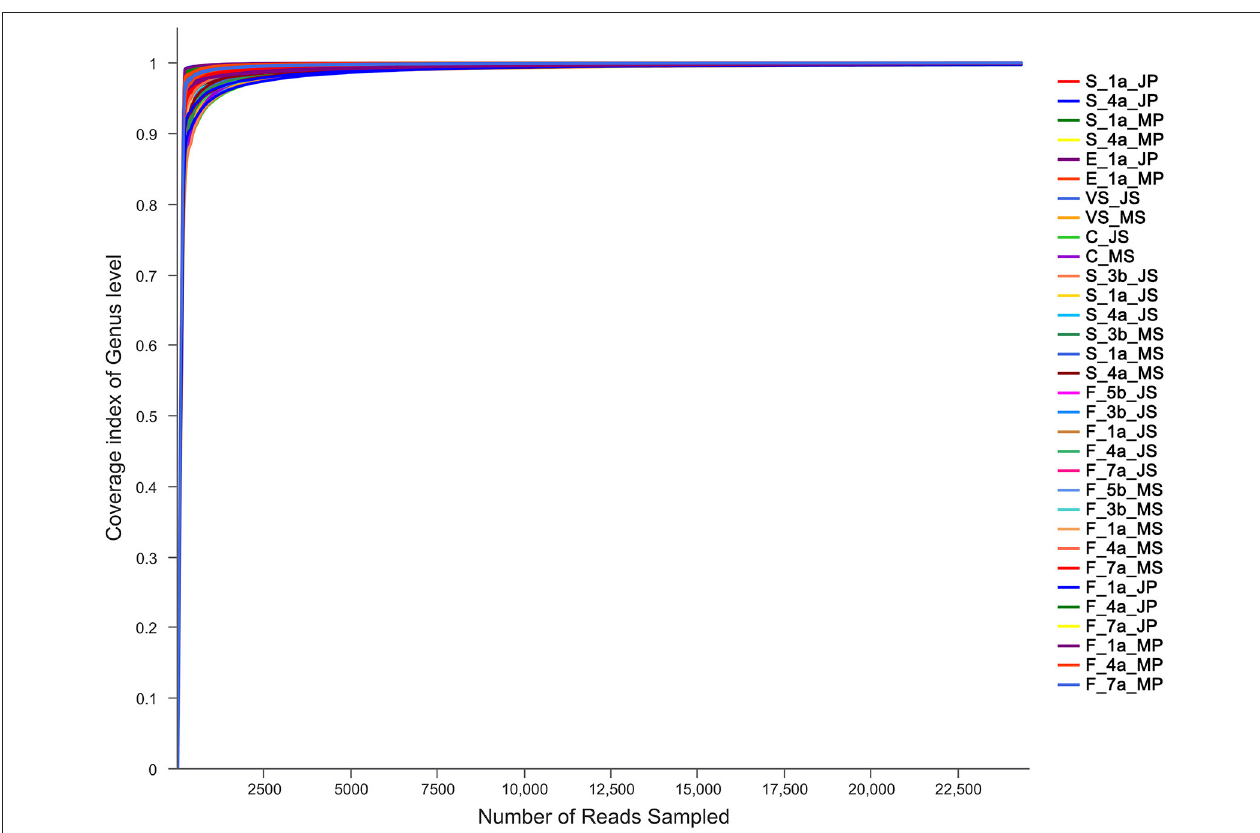
FIGURE 1 | Results of sequencing coverage of Mashen pig and Jinfen White pig. S, indicates the saliva samples; C, indicates the colostrum samples; F, indicates the fecal samples; VS, indicates the vaginal secretions; E, indicates the farrowing bed environment; JS, indicates Jinfen White sows; JP, indicates Jinfen White piglets; MS, indicates Mashen sows; MP, indicates Mashen piglets; 5 b indicates the samples collected at 5 d before sow parturition; 3 b indicates the samples collected at 3 d before sow parturition; 1a indicates the samples collected at 1 d after piglet birth or the day of sow parturition; 4a indicates the samples collected at 4 d after piglet birth or sow parturition; 7a indicates the samples collected at 7 d after piglet birth or sow